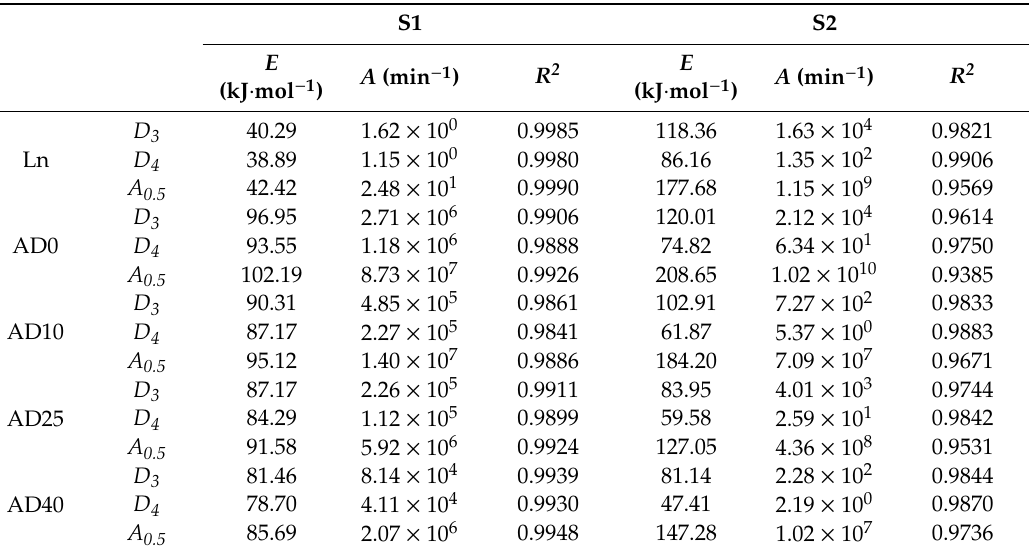
Table 4. The kinetic parameters of single samples.